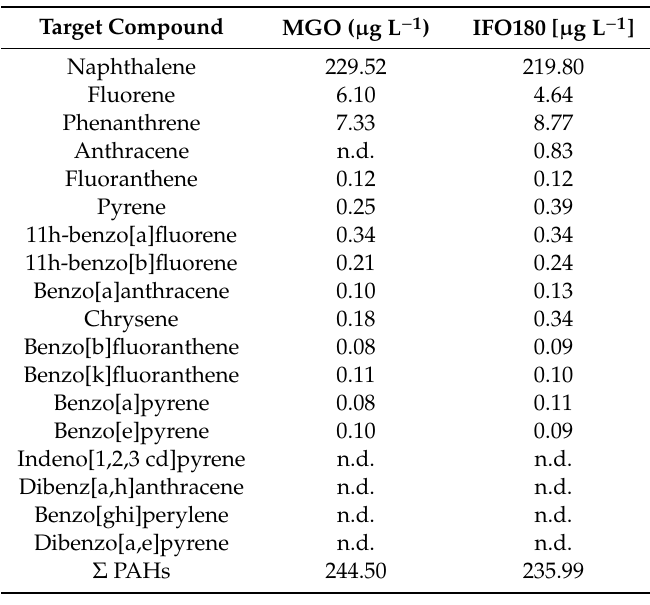
Table 1. Target PAHs in LEWAF stocks (1:50) for cell exposure. LEWAF stocks were prepared in double-deionized water. PAHs were extracted after 40 h of mixing at 10 ◦ C followed by 1 h of settling time using solid-phase micro extraction (SPME) for 2 h and analyzed using GC-MS. Results of the chemical analysis of NNS crude oil can be found in Johann et al. (2020) Table S1 in the SI. N.d. = not detected (below limits of quantification or limits of